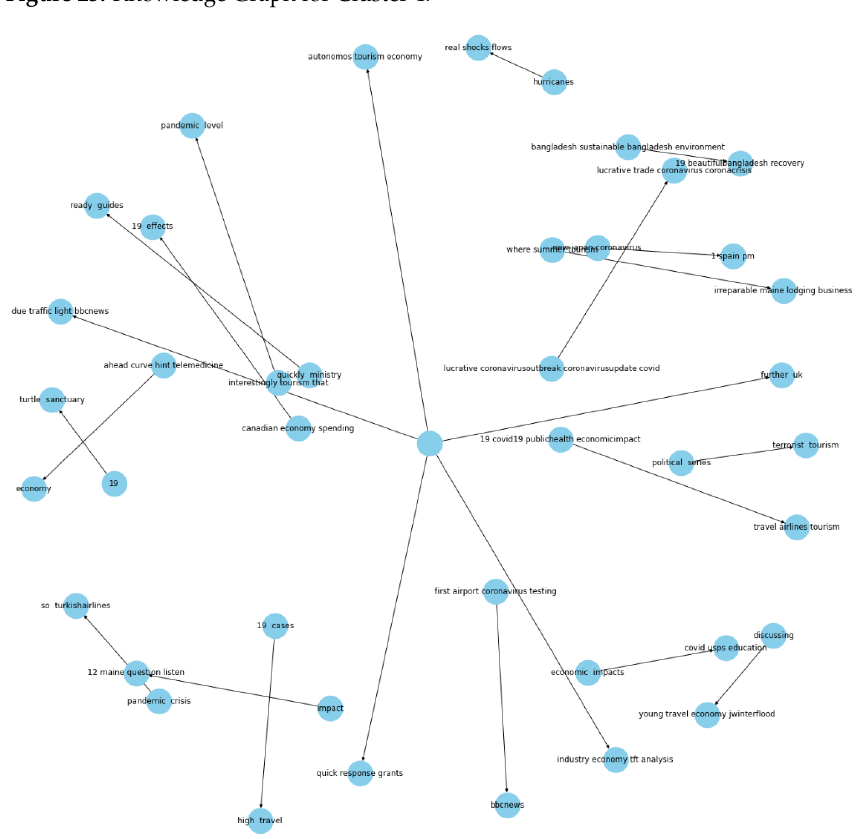
Figure 24. Knowledge Graph for Cluster 5.